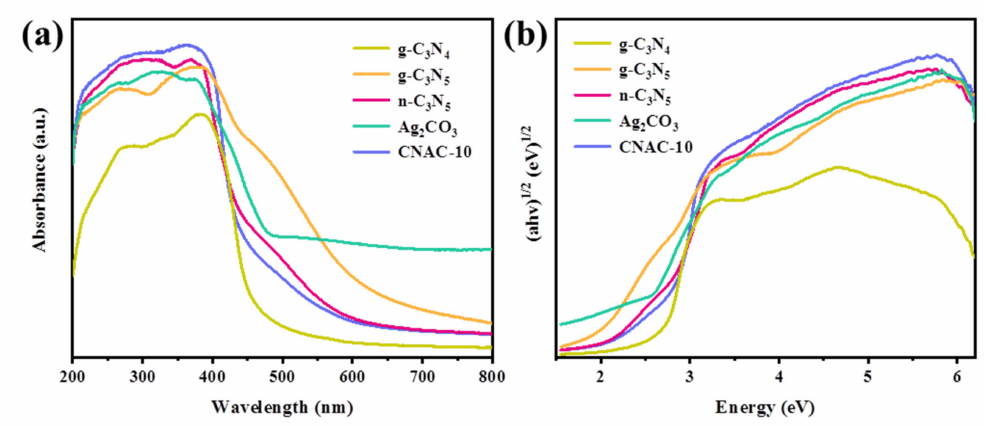
Figure 6. ( a ) UV–vis DRS spectra and ( b ) bandgap energy of photocatalysts.